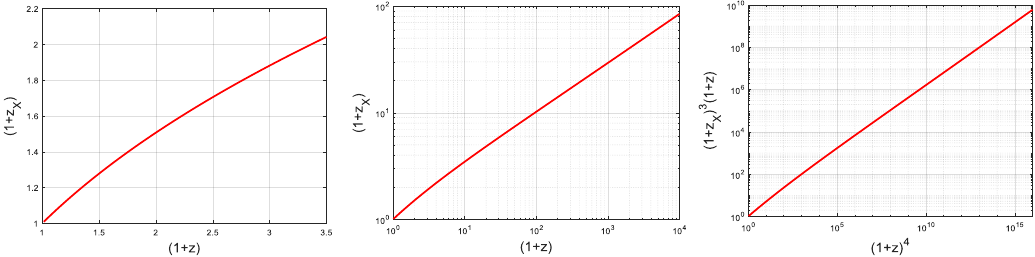
Figure 3. Evolution of inverse of scale factors and radiation density: inverse expansion scale factor 1/𝑎 𝑋 = (1 + 𝑧 𝑋 ) against the inverse standard scale factor 1/𝑎 = (1 + 𝑧) for low values ( left figure ) and high values ( middle figure ); radiation energy density scaling ( right figure ) for the nonadiabatic model EDSM-NA.